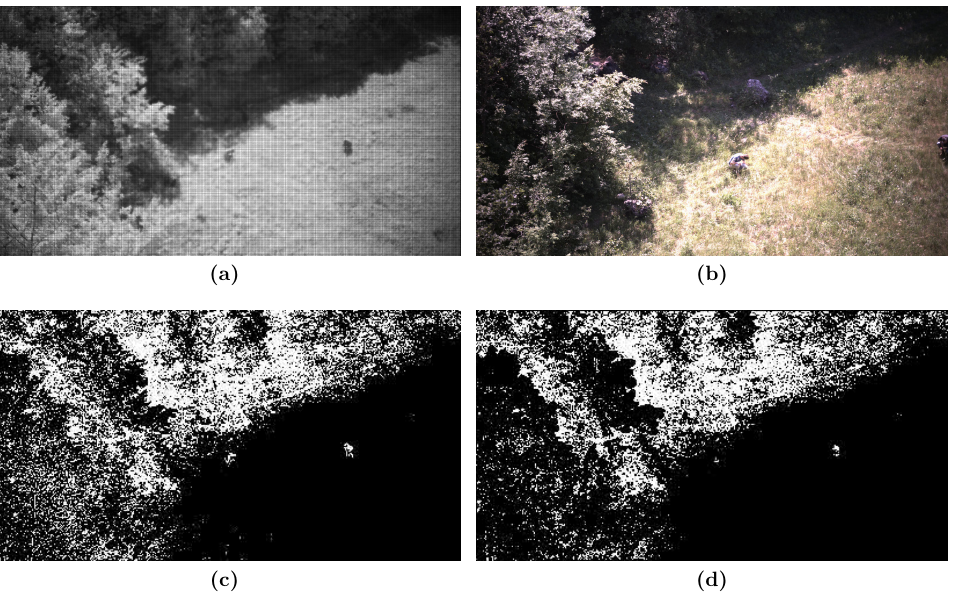
Figure 11. Aerial scenario (Quarry dataset), classification based on radiance: ( a ) Raw hyperspectral input frame. ( b ) Corresponding RGB frame. ( c , d ) Classification without and with spectral overlap supression, respectively. White: Classified as positive sample. Black: Classified as negative